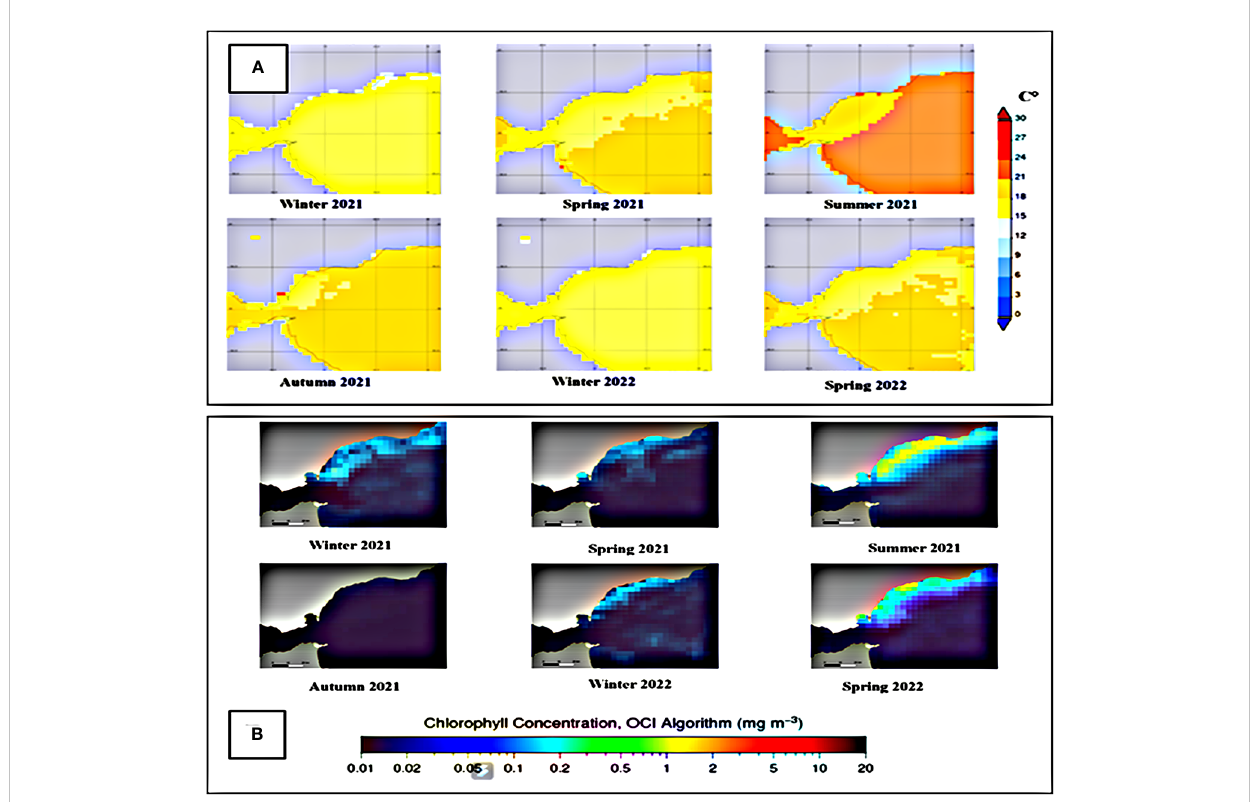
FIGURE 7 Average temperature (A) and chlorophyll (B) data from autumn 2021 to spring 2022.